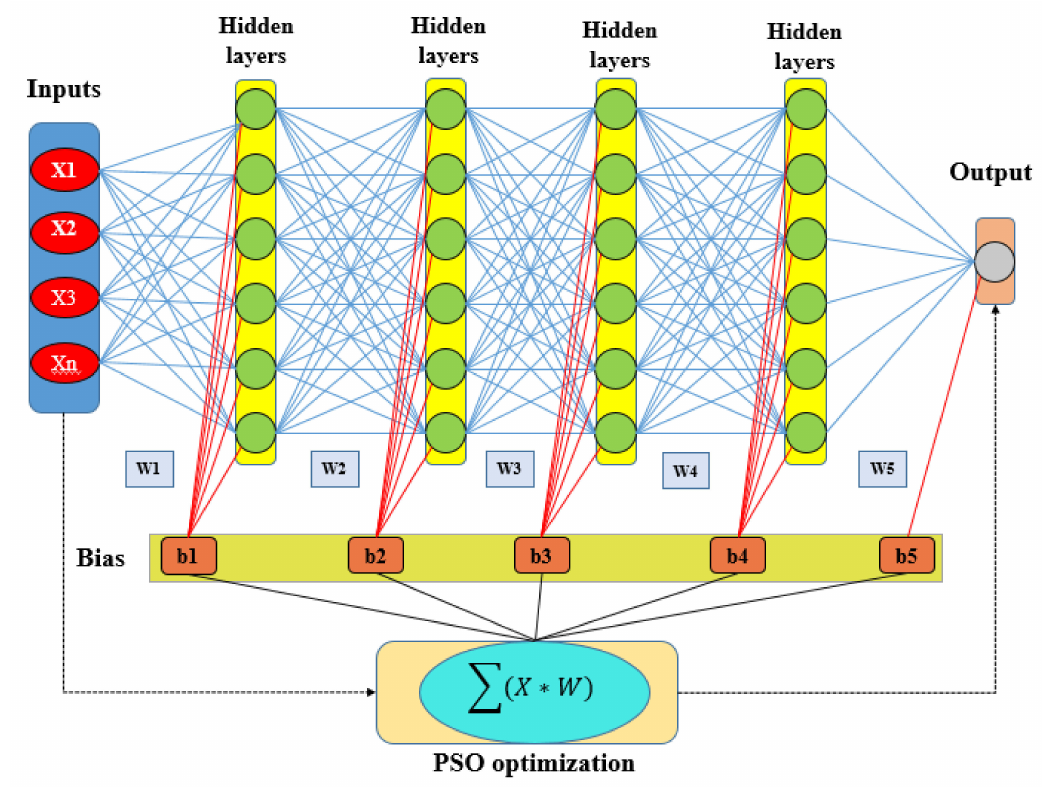
Figure 7. Schematic of ensemble particle swarm optimization and deep learning neural